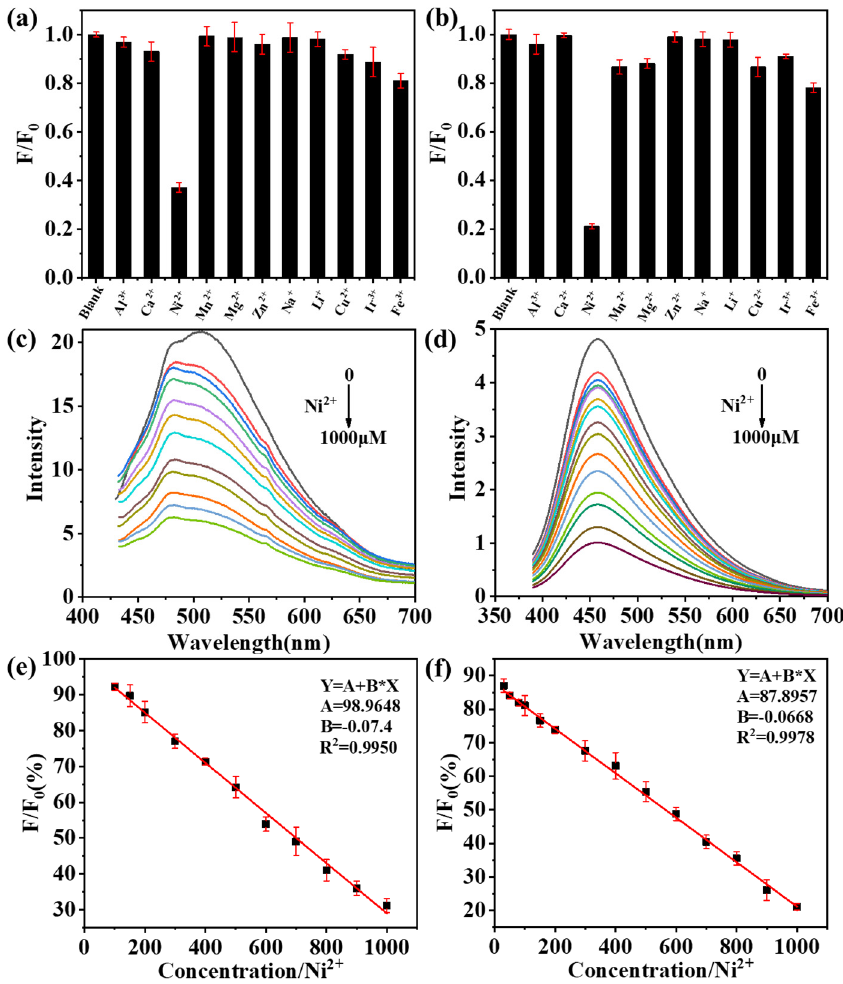
Figure 10. ( a , b ) Selectivity of CDs-Hydro and CDs-300 to different metal ions, F 0 and F present the fluorescence intensity of CDs before and after adding metal ions. ( c , d ) Fluorescence emission spectra of CDs-Hydro and CDs-300 after the addition of different concentrations of Ni 2+ . ( e , f ) Linear relationship between fluorescence intensity ratio of CDs-Hydro and CDs-300 solution and Ni 2+ concentration at different Ni 2+